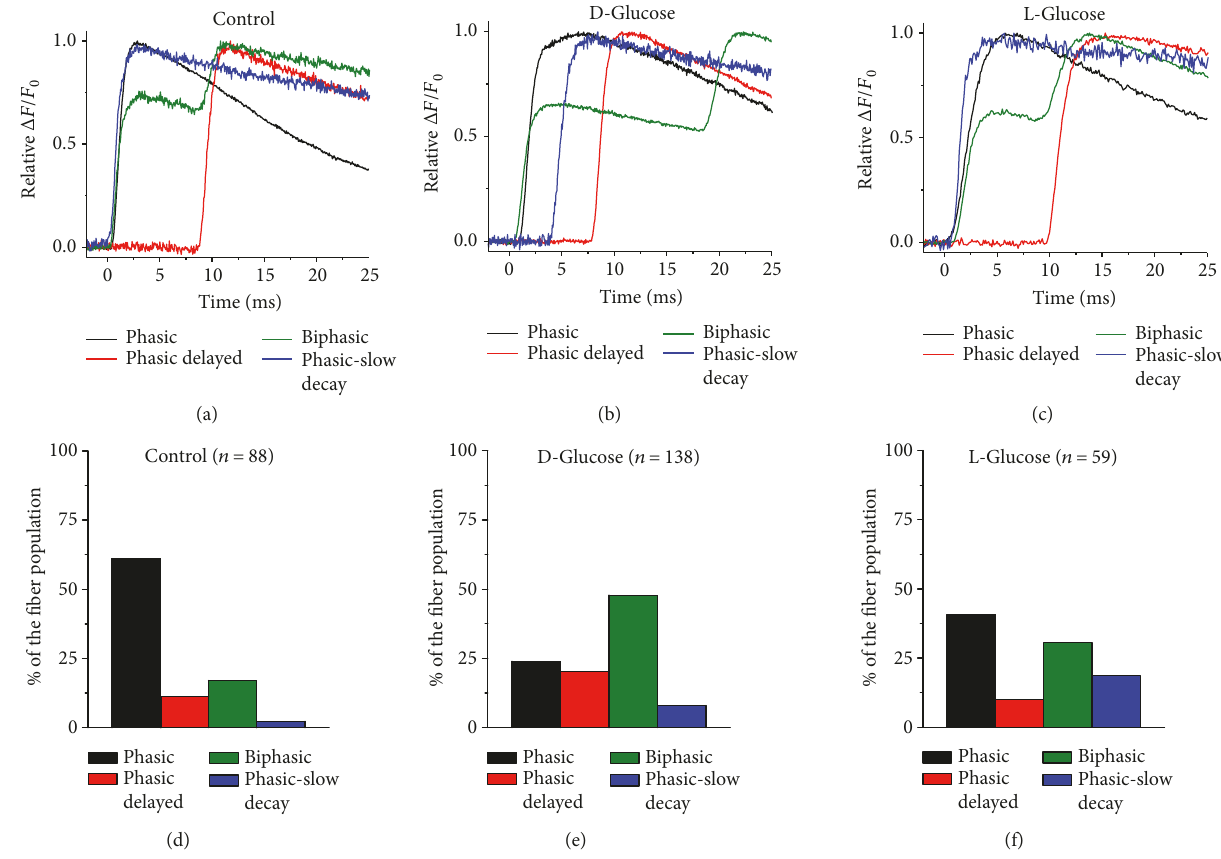
Figure 2: Sustained elevation of extracellular D-glucose modi fi es the distribution of AP-induced Ca 2+ transients observed in 5-day-old cultured fi bers. Zoomed-in and overlapped version of AP-induced Ca 2+ transients for control (a), D-glucose (b), and L-glucose (c) challenged fi bers. (d – f) Summary of distribution of AP-induced Ca 2+ transients for fi bers exposed to control isotonic medium (d), D-glucose (e), and L-glucose (f). Fibers exposed to D-glucose displayed a signi fi cantly larger proportion of biphasic action potential-induced Ca 2+ transients when compared to control counterparts ( X 2 , n = 286 , p value <